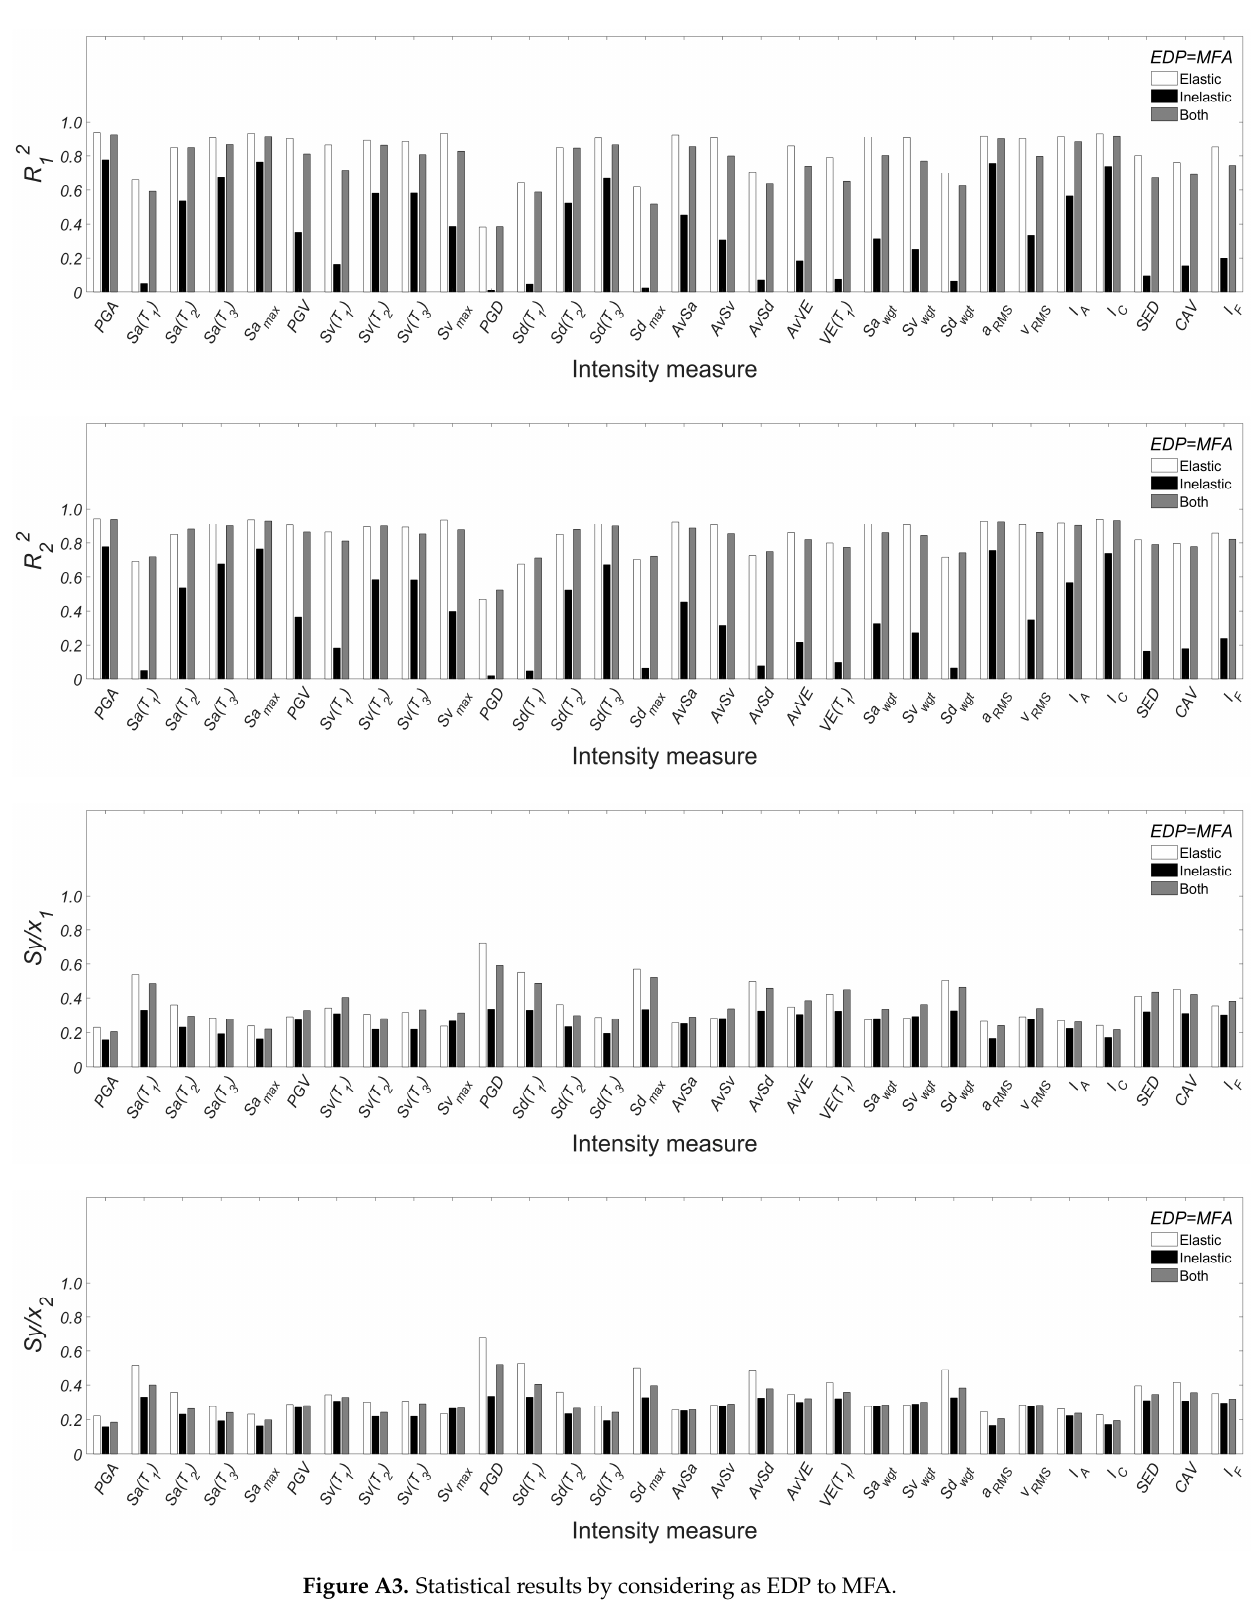
Figure A3. Statistical results by considering as EDP to MFA.